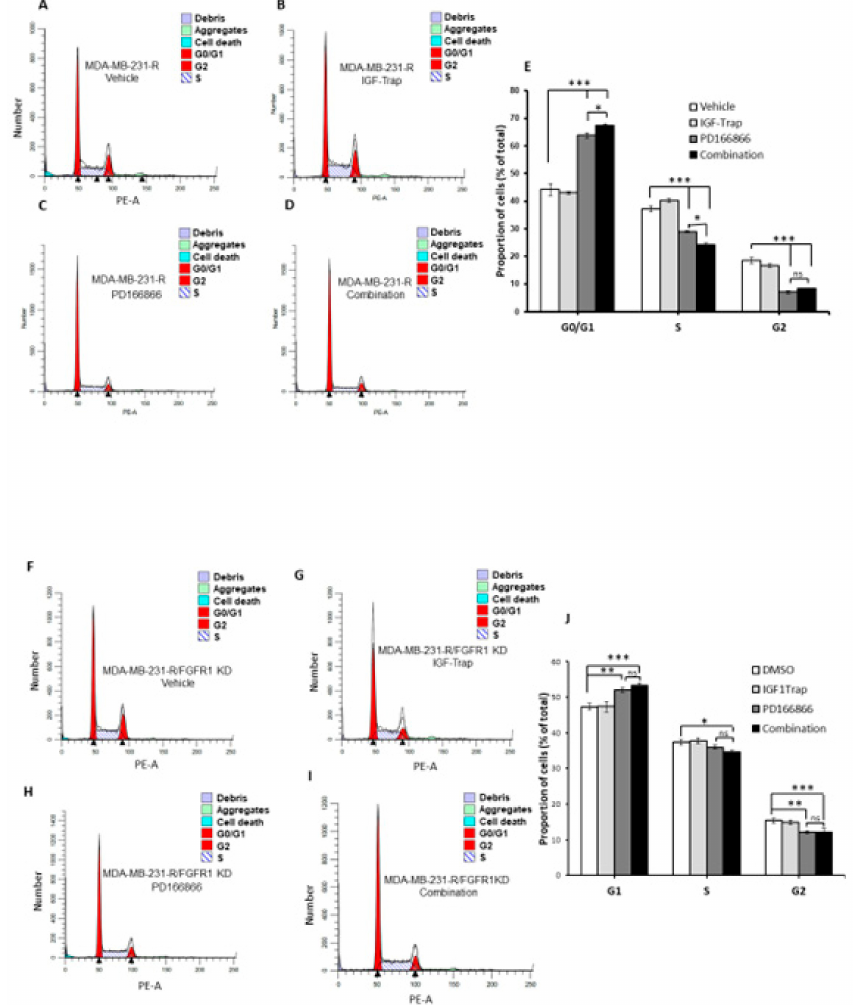
Figure 8. Combination FGFR and IGF-IR targeting enhances cell cycle arrest in MDA-MB-231-R cells. Cells were starved overnight and then cultured in DMEM medium containing 10% fetal bovine serum (FBS) with (or without) IGF-Trap (160 µ g/mL), PD166866 (20 µ M) or both for 48 h prior to cell cycle analysis. A single representative cell cycle profile is shown for MDA-MB-231-R ( A – D ) and MDA-MB-231-R cells in which FGFR1 was silenced using shRNA (MDA-MB-231-R/FGFR1 KD cells ( F – I ) treated with vehicle ( A , F ), IGF-Trap ( B , G ), PD166866 ( C , H ) or combination of the two ( D , I ). The proportions of cells (%) in the different cell cycle phases are shown in the bar graphs ( E , J ). * p < 0.05, ** p < 0.01, *** p <